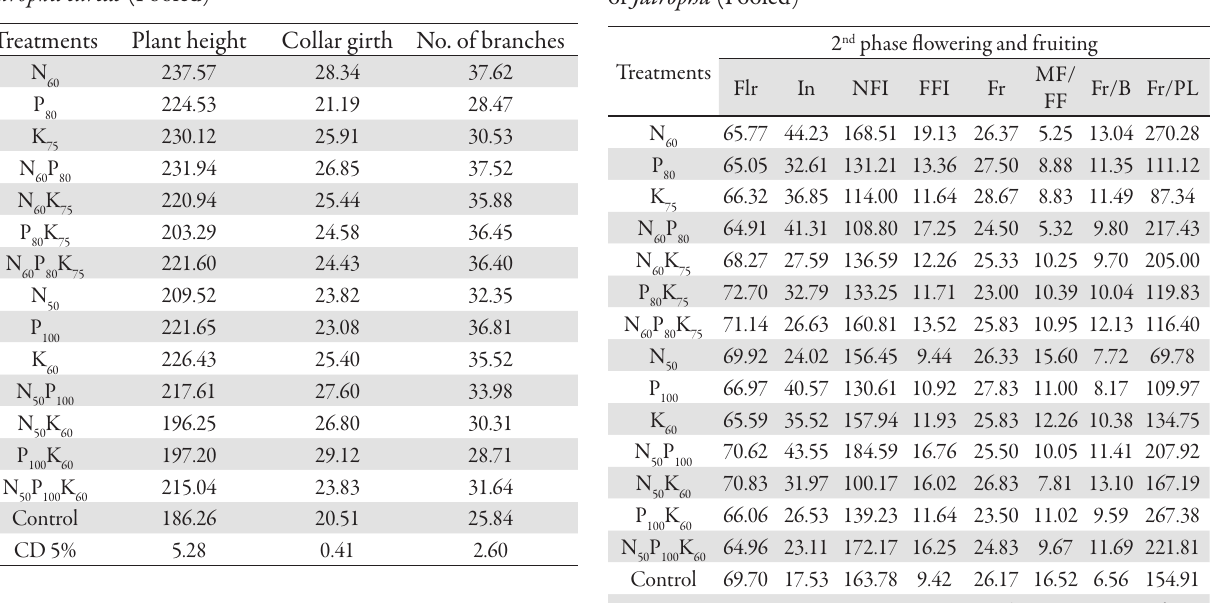
Tab. 1 Effect of N, P and K on growth characteristics of Jatropha curcas (Pooled)